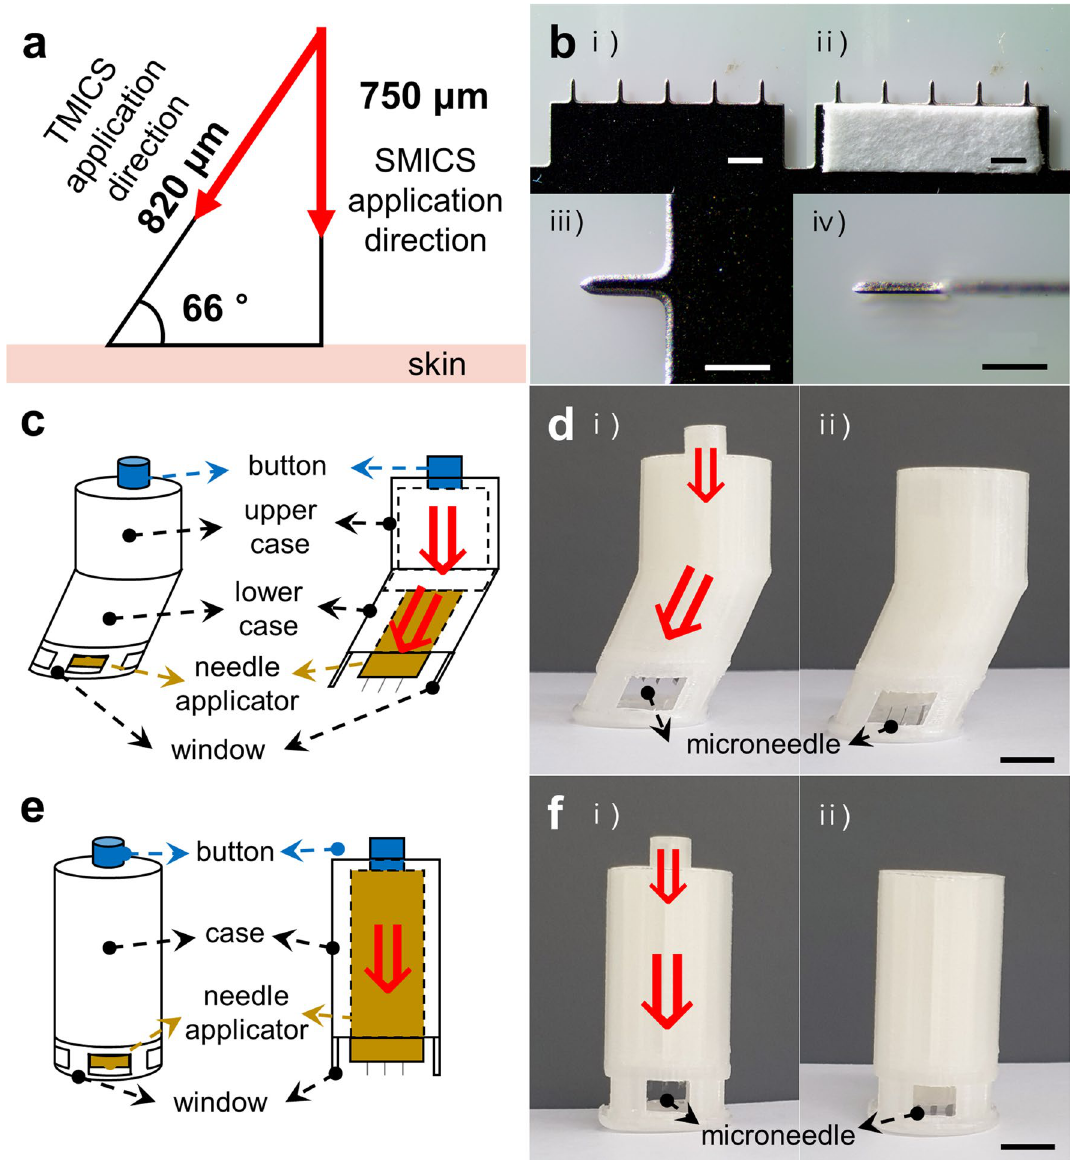
Figure 1. Information about TMICS, SMICS, and MN. ( a ) A schematic diagram showing information of TMICS: The insertion angle is 66° and the penetration depth is 820 μm. ( b ) Optical images of a stainless microneedle array (i) and the MN array attached a paper reservoir (ii). The scale bars in (i) and (ii) are 1 mm. The magnified images of a microneedle top view (iii) and side view (iv). The scale bars in (iii) and (iv) are 500 μm. ( c ) Schematic illustration of TMICS. ( d ) Digital images of TMICS before MN application (i) and after MN application (ii). The scale bar in ( d ) is 1 cm. ( e ) Schematic illustration of SMICS. ( f ) Digital images of SMICS before MN application (i) and after MN application (ii). The scale bar in ( f ) is 1 SMN patch (without the device) could collect 1.22 ± 0.66 μL of ISF, and SMICS and TMICS extracted 0.97 ± 0.32 and 2.28 ± 0.39 μL of ISF, respectively (one-way ANOVA, p < 1.7 × 10 –5 ). When ISF was extracted with TMICS, the extracted amount was increased by 2.4 times that of SMICS. Com- paring the skin contact area of the MNs used to TMICS and SMICS, the contact area increased by 9.5% when TMICS was used than SMICS. It means that the contact area of 0.0185 mm 2 per MN, and 0.0925 mm 2 per patch (five MNs) increased. As a result, compared to the increase of the penetration surface area, the amount of ISF extraction increased dramatically, and it can be seen that widening the surface area is critical for increasing the amount of ISF extraction. SMN (without the device) extracted more ISF than a single MN patch of SMICS (Fig. 4b). The reason is that since SMICS has a constant insertion angle of 90° controlled by the 3D printed device, the contact area of the MNs to the skin is minimized. On the other hand, the SMN performed by hands has an inconsistent insertion angle, increasing the MN contact area and ISF extraction. When analyzing the extraction amount of each MN device,